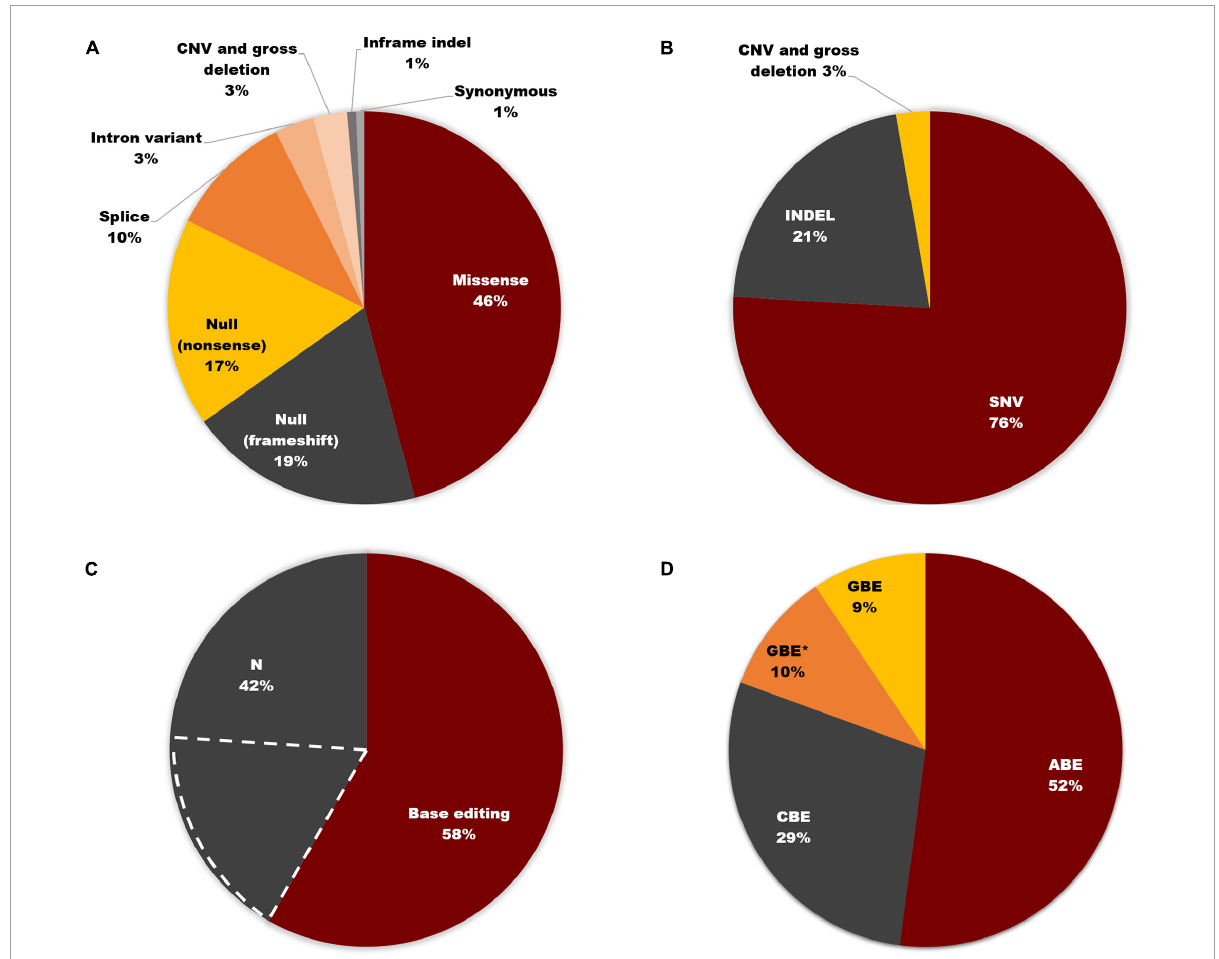
FIGURE6 Base editing on USH2A . (A) Distribution of USH2A mutation types ( n = 3,972 alleles). (B) SNVs account for 76% of all USH2A variants. (C) 58% of total variants can be corrected according to the editing principle of ABE, CBE, and GBE. The region marked by dashed white lines represents the SNVs that cannot be restored by three base editors. (D) Proportion of SNVs that can be corrected by different base editors. GBE with an asterisk (GBE*) represents SNVs in which the mutant nucleotide cannot be corrected through the original editing principle of ABE, CBE, and GBE, but the amino acid encoded will be restored by changing another base within the same codon using